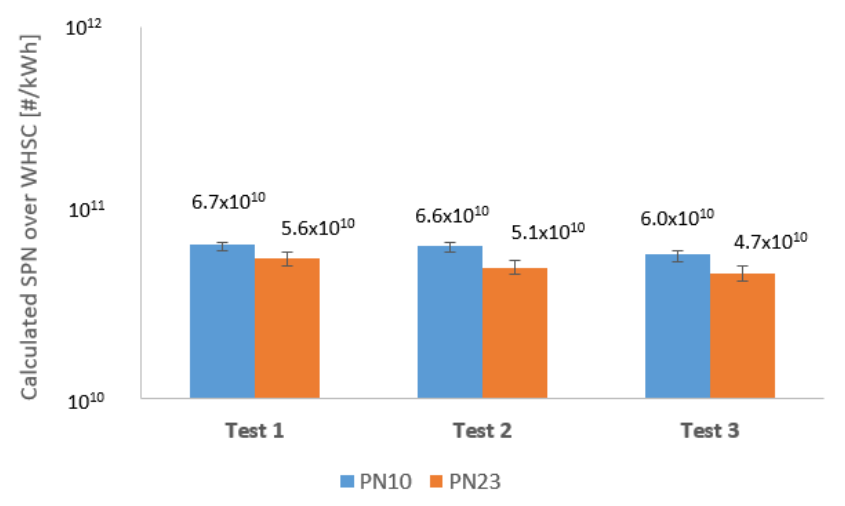
Figure 10. Calculated solid particle number results of each individual test, with DPF.